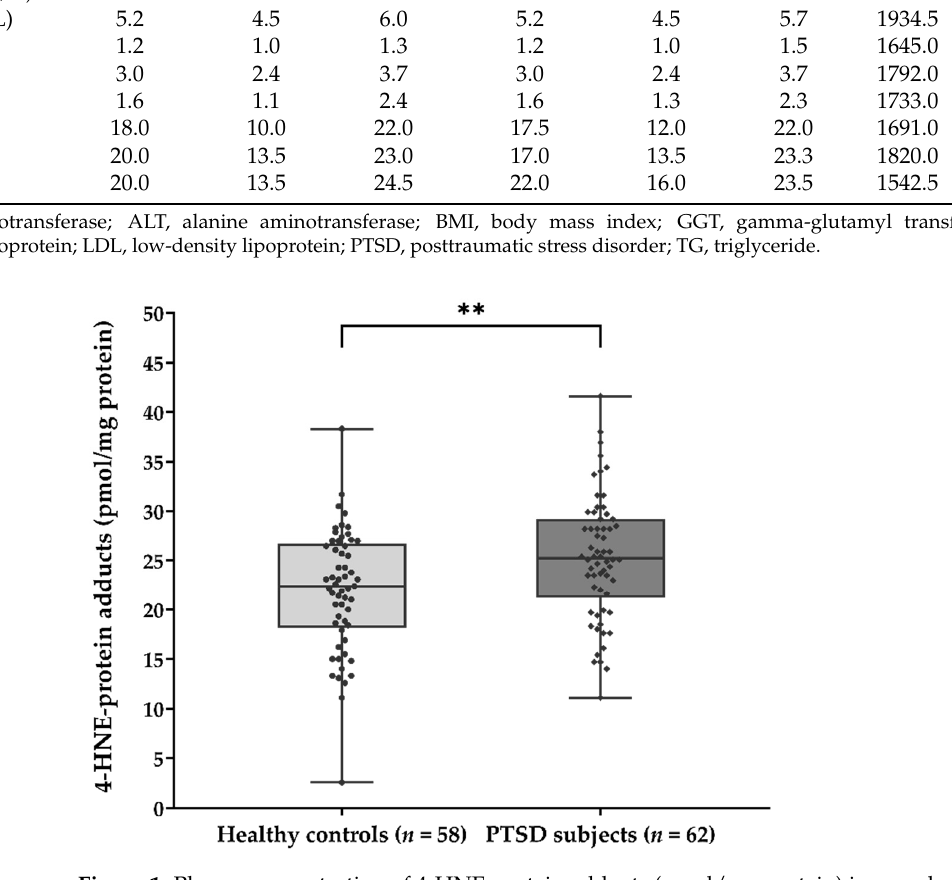
Figure 1. Plasma concentration of 4-HNE-protein adducts (pmol/mg protein) in samples of healthy controls ( n = 58) and PTSD subjects ( n = 62). Results are presented as a box and whisker plot. The median is represented by the line in the box, while the interquartile range (IQR) box represents the middle quartiles (the 75th minus the 25th percentile). The whiskers on either side of the IQR box represent the lowest and highest quartiles of the data. The ends of the whiskers represent the maximum and minimum of the data. ** p = 0.006. 4-HNE, 4-hydroxynonenal; PTSD, posttraumatic stress disorder.